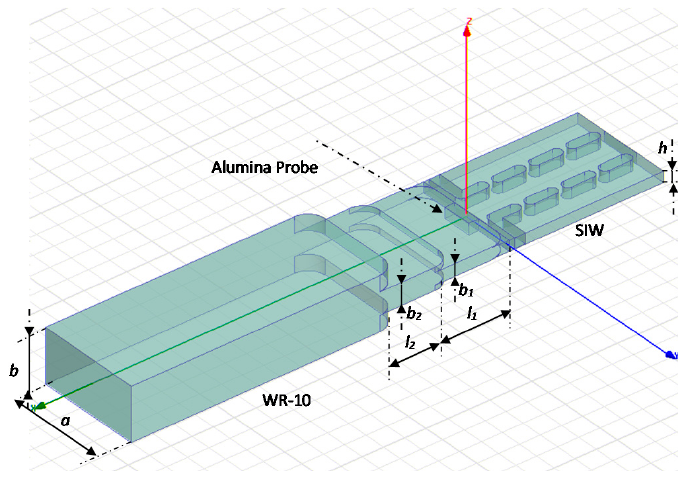
Figure 7. Details of the SIW standard WR-10 transition.